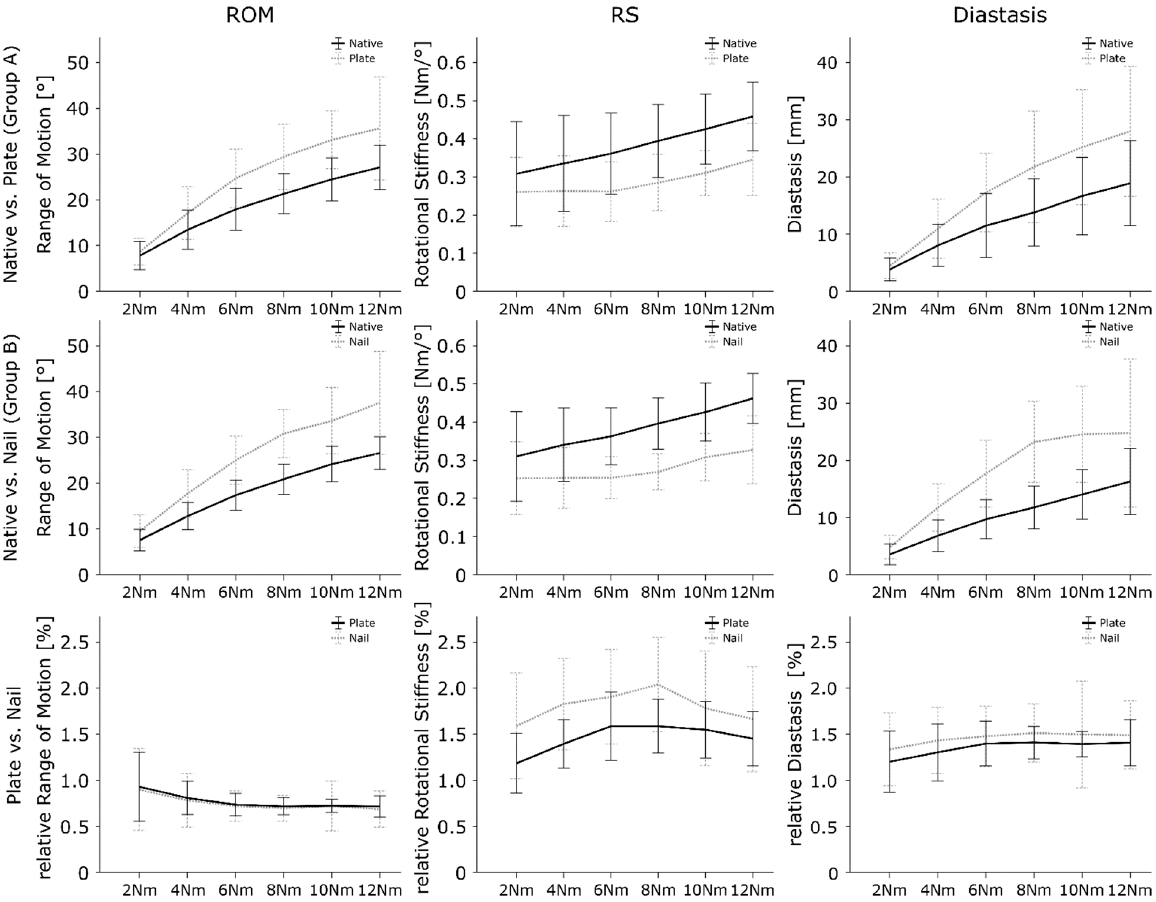
Figure 3. Results for the ROM, RS, and diastasis for native condition versus plate fixation (row 1), native condition versus nail fixation (row 2), and plate versus nail fixation (row 3). The data are presented with 95% confidence intervals. Non-overlapping intervals indicate significant differences.